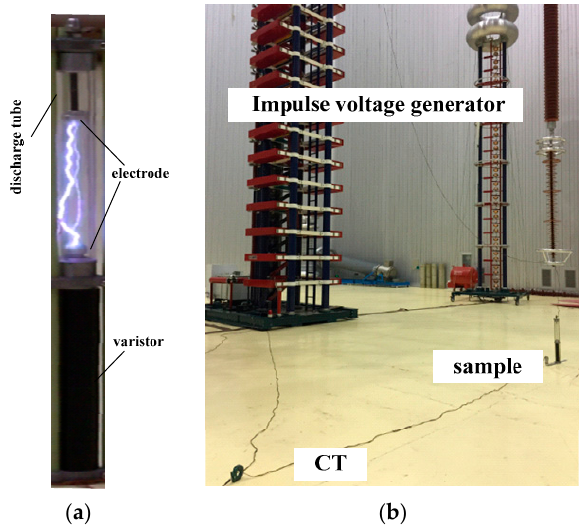
Figure 2. Experimental sample and platform: ( a ) the internal-gap lightning protection device (ILPD) sample and ( b ) the experimental platform.